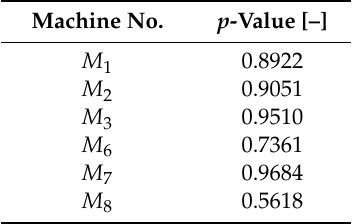
Table 3. Markov process identification